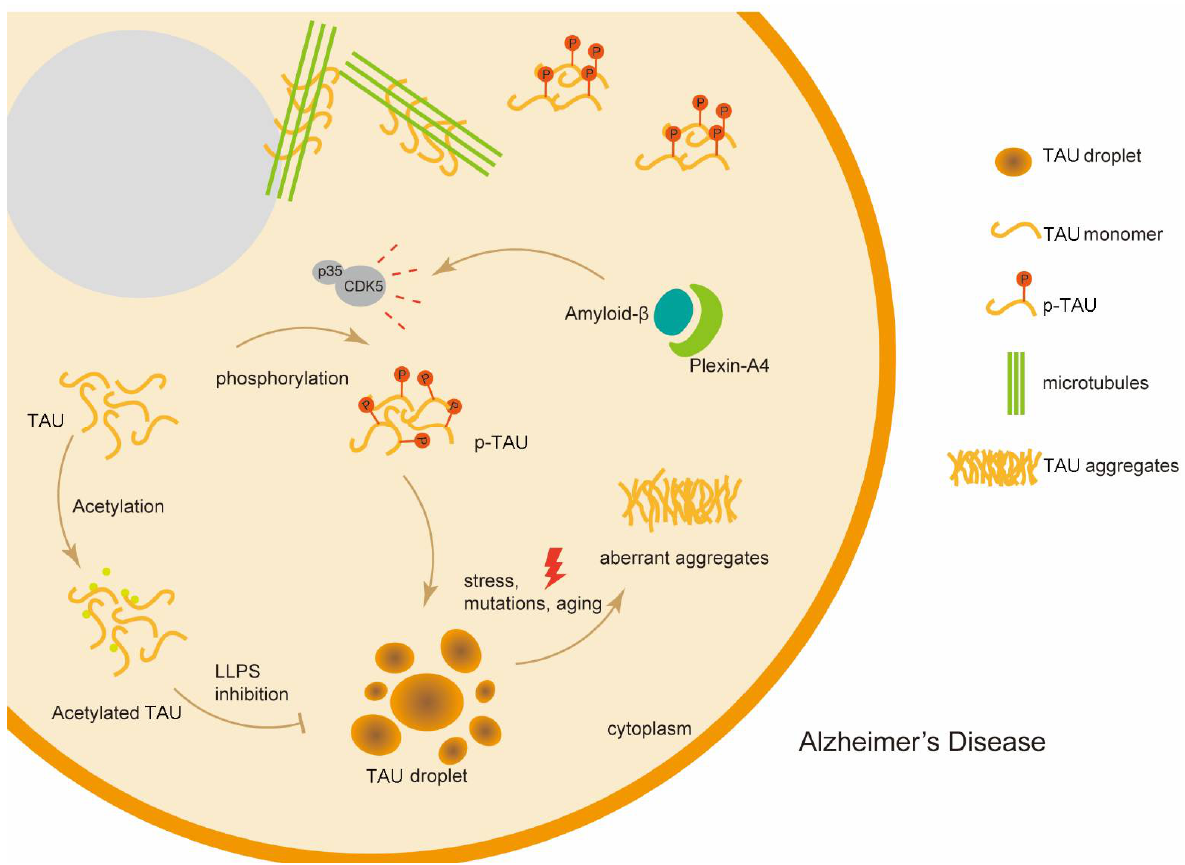
Figure 3. Amyloid proteins TAU and Aβ aggregates in brains of Alzheimer’s disease patients (AD). Post-transcriptional control, stress, or mutations altered the behaviors of TAU-triggered LLPS, which subsequently induced aberrant aggregates of TAU and resulted in pathology of AD. Aβ aggregated as amyloid plaques through LLPS and interacted with plexin-A4 proteins thus leading to AD.